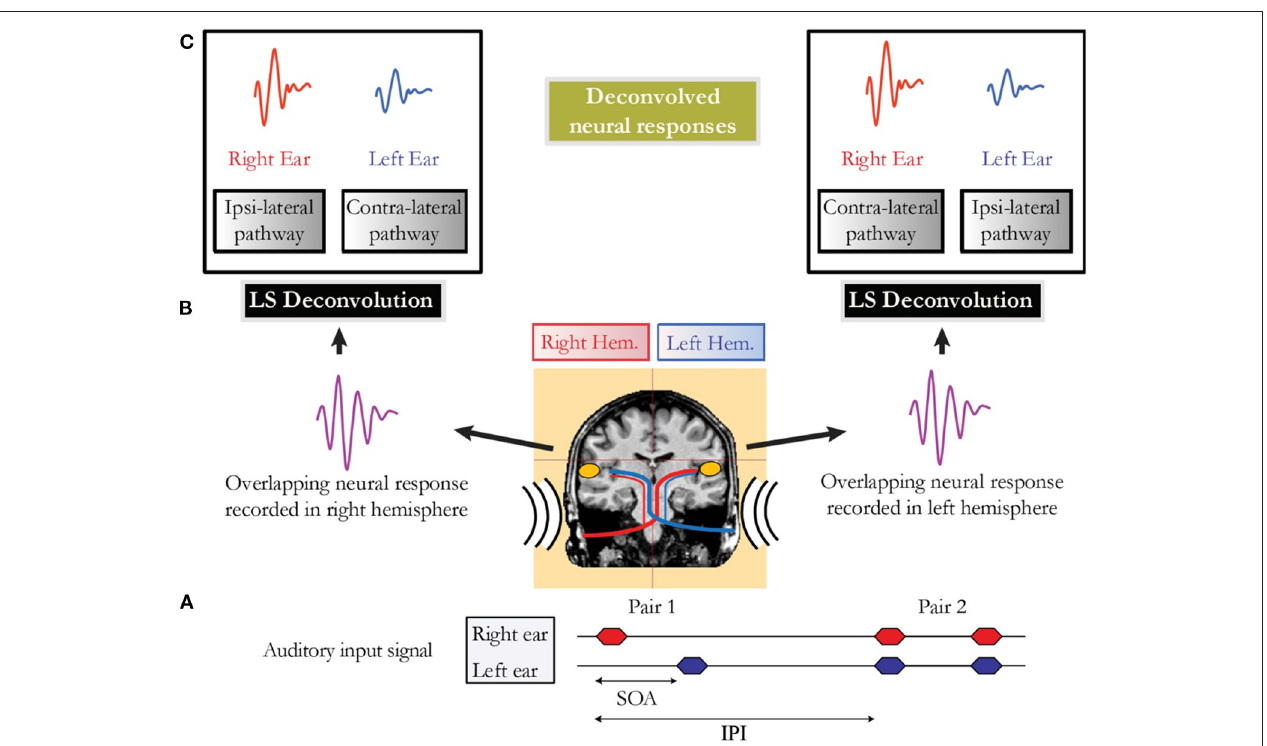
FIGURE 1 | (A) Schematic representation of the auditory input signal for a sequential presentation condition (e.g., Pair 1) followed by a binaural presentation condition (e.g., Pair 2). The stimulus onset asynchrony (SOA) that represents the timing between the onset of the two auditory stimuli of a pair is jittered to allow deconvolution. The time interval between the onset of two pairs is referred as the inter-pair interval (IPI). (B) Representation of the overlapping neural activity of Pair 1. The MEG signal is recorded in both hemispheres in response to the first auditory stimulus presented to the right ear, followed closely by a stimulus presented in the left ear. (C) Deconvolved neural responses in each auditory cortex obtained using the least-squares (LS) deconvolution